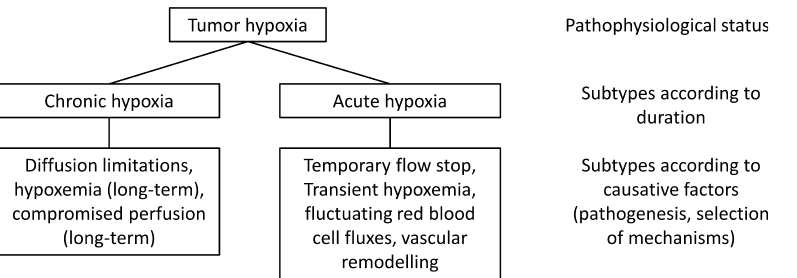
Fig. 1. Classi¯cation of tumor hypoxia according to duration (traditional classi¯cation), and systematization based on patho- genetic (causative) mechanisms.